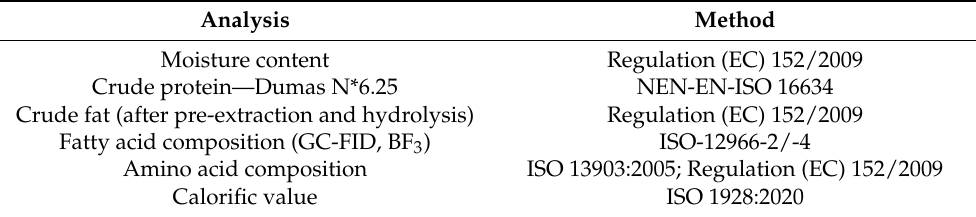
Table 7. Compositional analyses of feed performed during this study.